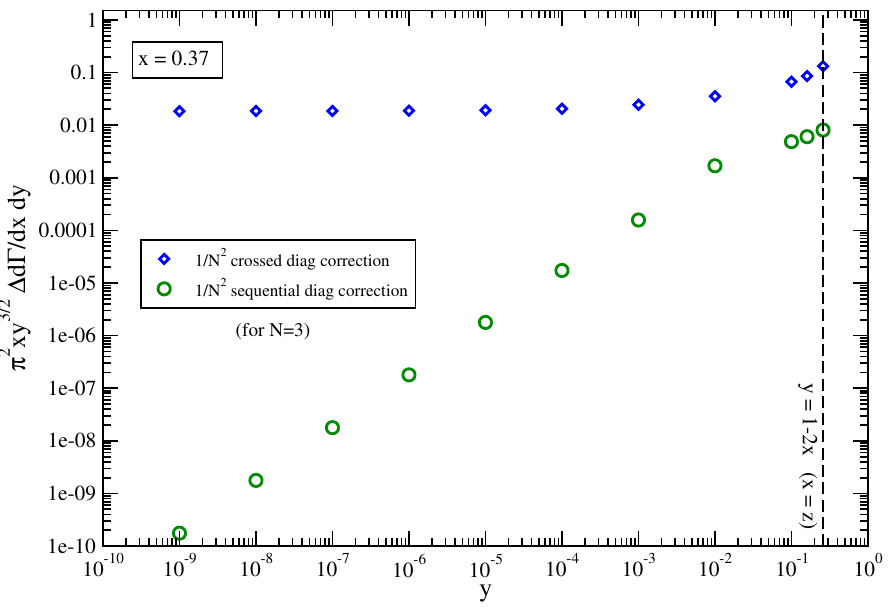
Figure 20 . A plot for x = 0 . 37 of the y dependence of the different 1 /N 2 contributions to ∆ d Γ /dx dy , multiplied by π 2 xy 3 / 2 as in figure 18. Note that, in contrast to figure 19, we have not divided by ln(1 /y )